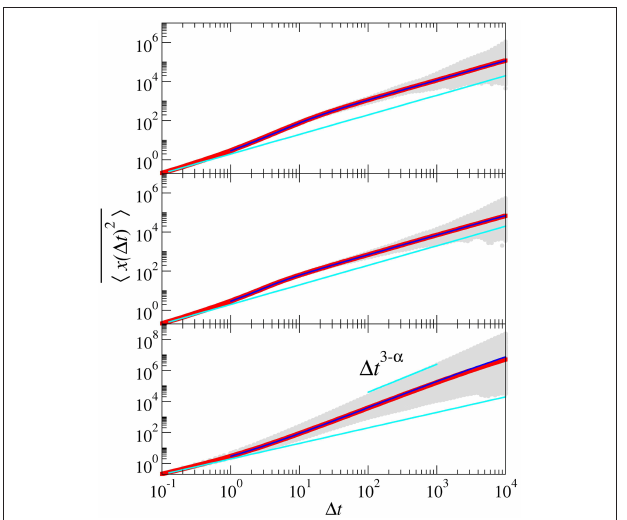
10 4 , δ t 0.001, and = = D / D / √ σ , [ t ] σ ˜ = ˜ =